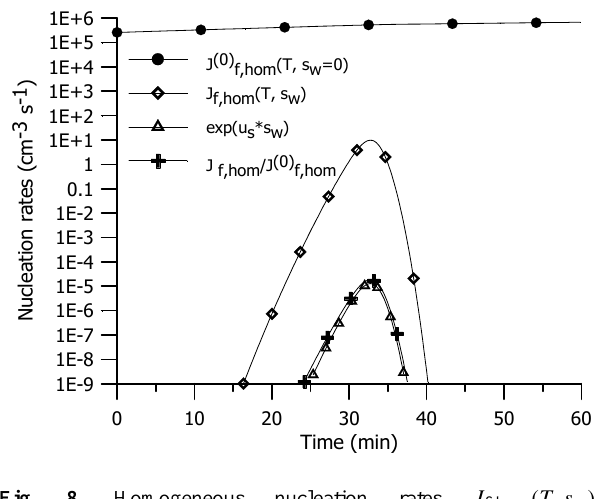
01E-91E-81E-71E-61E-51E-41E-31E-20.111E+11E+21E+31E+41E+51E+6 50 6 Time (min) Fig. 8. Homogeneous nucleation rates J f , hom (T,s w ) , Fig. 8. Homogeneous nucleation rates , , their ratio ),( hom, wf sTJ )0,( )0( hom, = wf sTJ J ( 0 ) (T,s w = 0 ) , their ratio J f , hom (T,s w )/J ( 0 ) (T,s w = 0 ) , f , hom f , hom , and exp( u )0,(/),( )0( hom,hom, = wfwf sTJsTJ s s w ) that determines this ratio. Calculations for the and exp( u s s w ) that determines this ratio. Calculations for the same same conditions as in Fig. 7. It is seen that J f,hom / J (0) f,hom is very close to exp( us w ), which is a good conditions as in Fig. 7. It is seen that J f , hom /J ( 0 ) f , hom is very approximation to this ratio. close to exp( us w ) , which is a good approximation to this